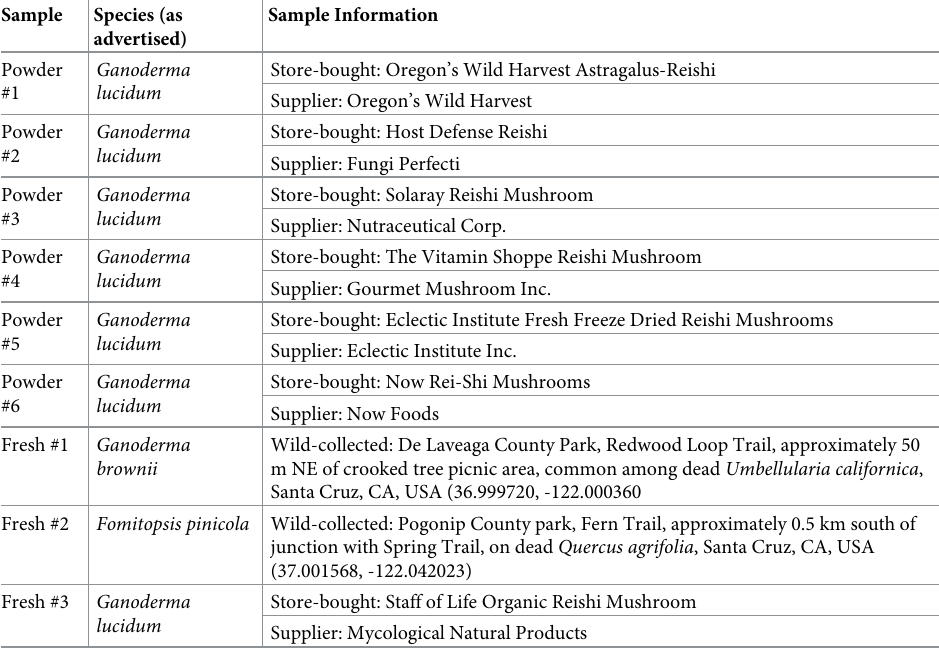
Table 1. Sampling information for powdered and fresh samples that were store-bought or